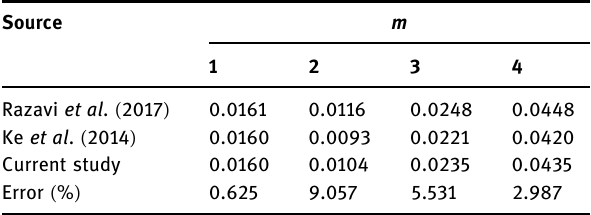
Table 2: Comparing the dimensionless natural frequency for simply supported cylindrical shell with those of previously published works